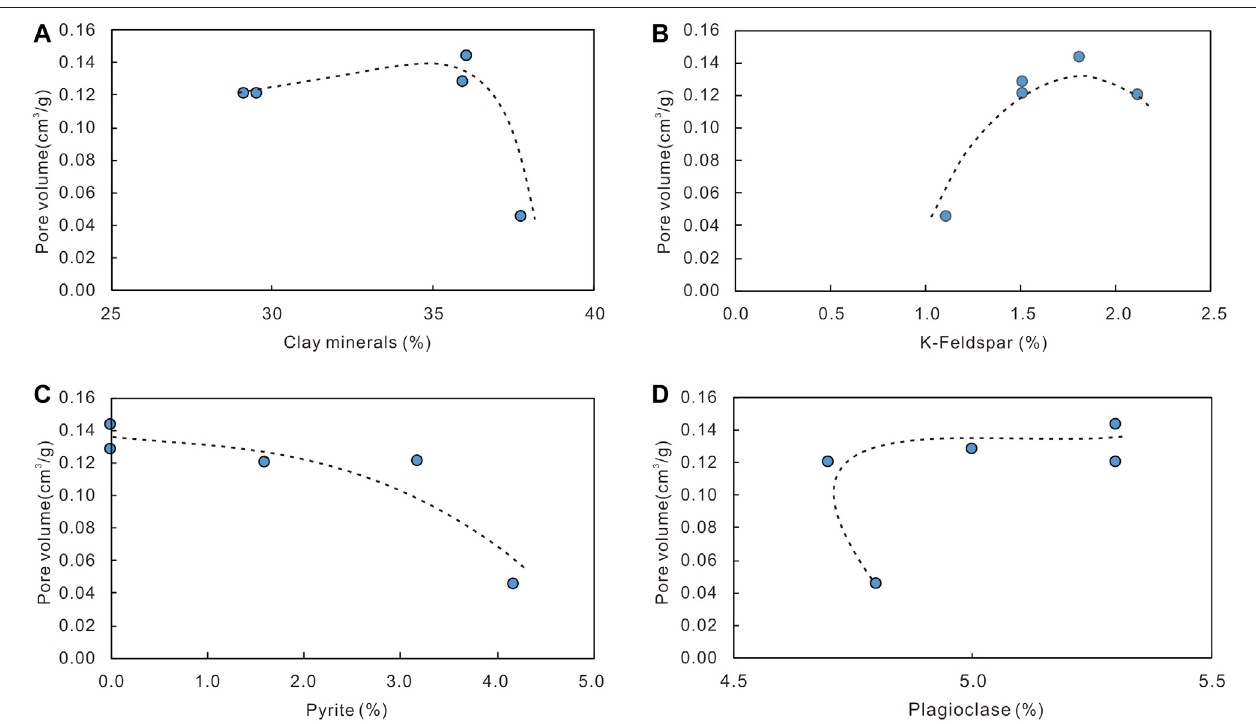
FIGURE10| Relationshipamongdifferentmineralsandporevolume. (A) -claymineralsvsporevolume, (B) -feldsparvsporevolume, (C) -pyritevsporevolume, (D) - plagioclase vs pore volume.